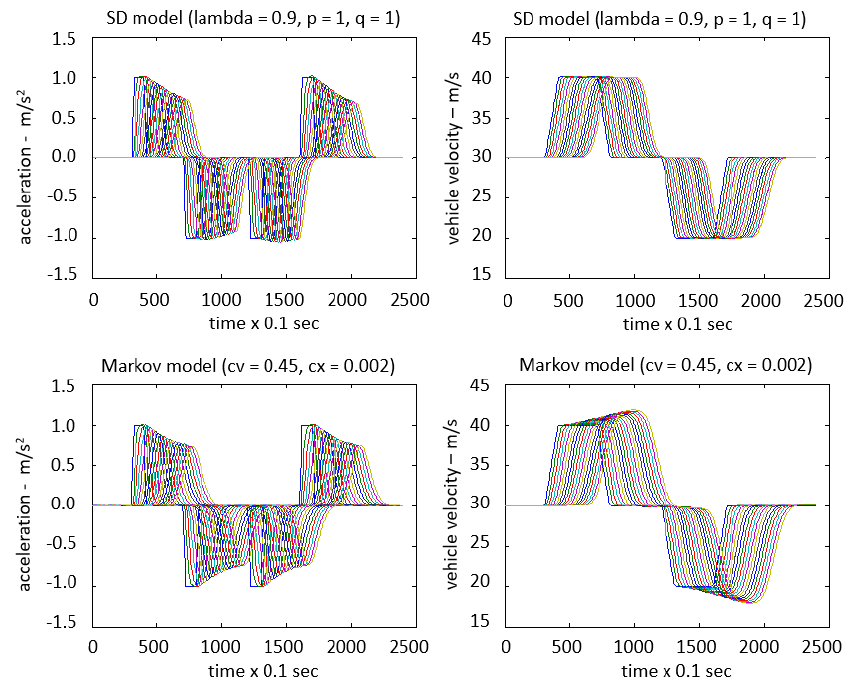
Figure 19. Verification results for comparison of the SD and Markov drone following models.